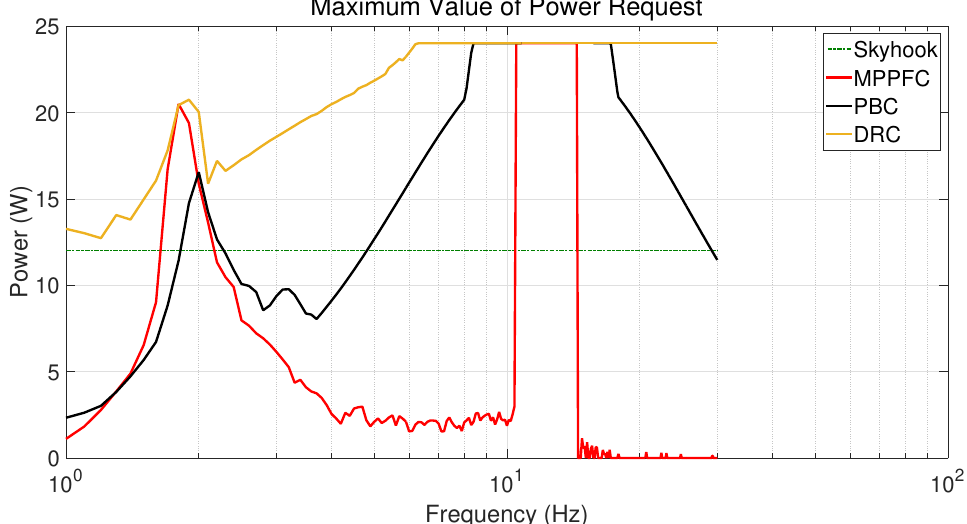
Figure 13. MRD power consumption for the proposed SAC